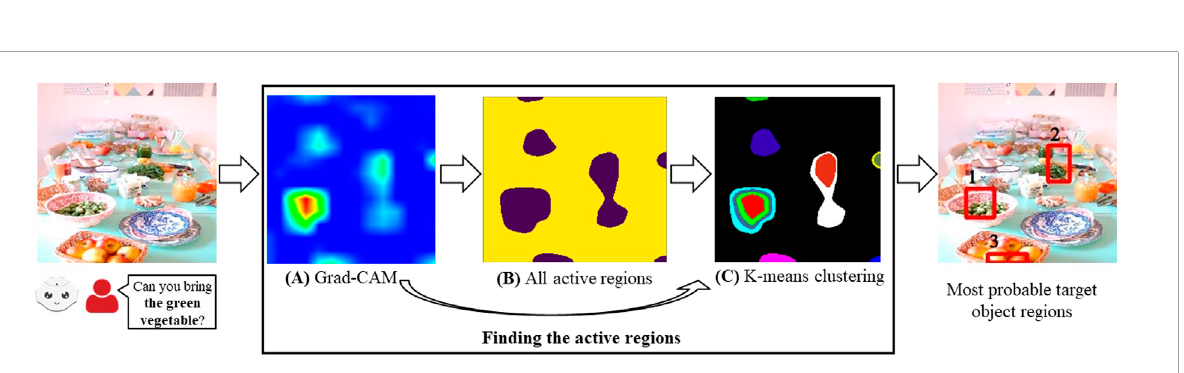
FIGURE 2 Overview of the Grad-CAM RGB method to find the described object regions for a given RGB scene and a referring expression (the bold part of the user’s expression corresponds to the referring expression). The heatmap generated by Grad-CAM in (A) , all active regions in (B) , and the results from K-means clustering in (C)